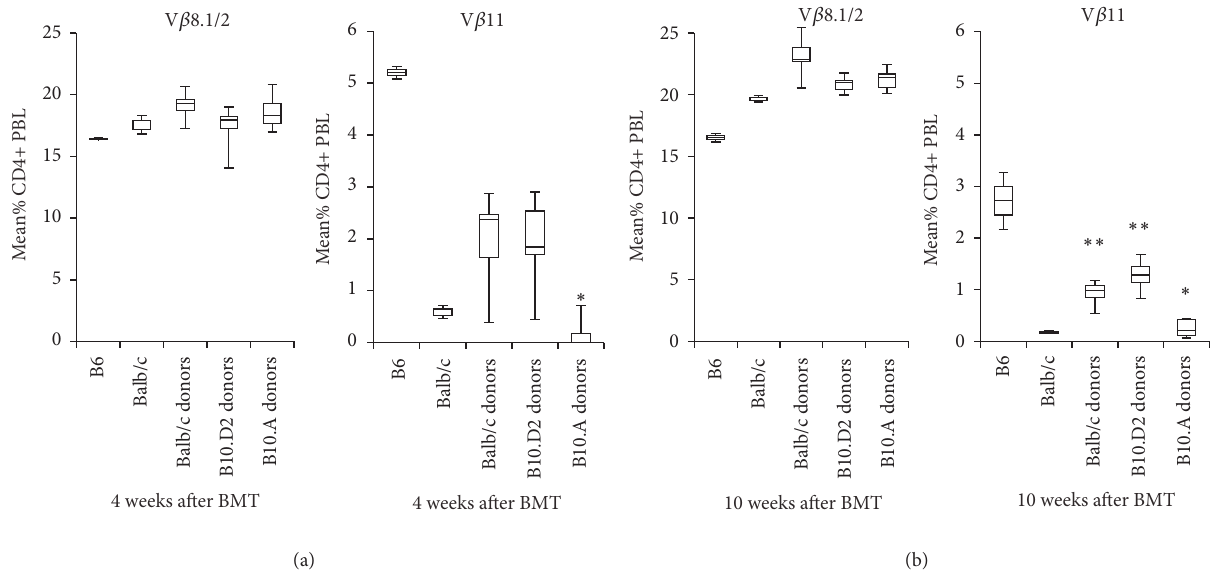
Figure 3: Deletion of donor-reactive T cells differs among donor strains. (a) Deletion of donor-reactive T cells was investigated through determination of the percentage of V 𝛽 11 + and V 𝛽 8.1/2 + CD4 + PBL by 2-color flow cytometric analysis 4 weeks after BMT. Deletion of V 𝛽 11 + CD4 + PBL in Balb/c (H 2 d , mHAg mismatched, 𝑛 = 8 ) and B10.D2 (H 2 d , mHAg matched, 𝑛 = 11 ) BMC recipients developed to a similar dimension irrespective of differing mHAg disparities of donor to recipient. In mice which were transplanted with BMC of B10.A (H 2 a , mHAg matched, 𝑛 = 9 ) a significant increase of early deletion compared to BMT of Balb/c (H 2 d , mHAg mismatched) and B10.D2 (H 2 d , mHAg matched) donors was observed ( ∗ 𝑝 < 0.05 versus Balb/c and B10.D2 BMC recipients). The percentage of V 𝛽 8 + CD4 + cells was not significantly reduced in any group compared to na¨ıve BL6 mice indicating the specificity of the deletion for superantigens presented by the donor. (b) Ten weeks after BMT the degree of deletion was significantly enhanced in long time chimeras after Balb/c and B10.D2 BMT but still was significantly less pronounced than in recipients of B10.A BMC. Mean percentages of V 𝛽 11 + and V 𝛽 8.1/2 + CD4 + PBL, interquartile range (box), and SD (whiskers) of long-term chimeras are shown as box-and-whisker blots. Representative data from one of two independent experiments. Statistical significance determined by log-rank test. ∗ 𝑝 < 0.05 versus Balb/c donors; ∗∗ 𝑝 < 0.01 versus week 4 after BMT (each